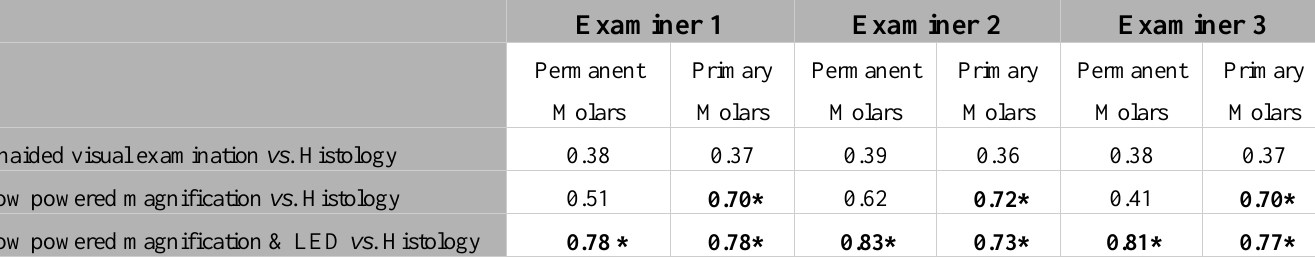
Table 9. Spearman’s correlation coefficients for examiners showing the relationships between examinations using Downer classification systems. * Correlation significant at the 0.05